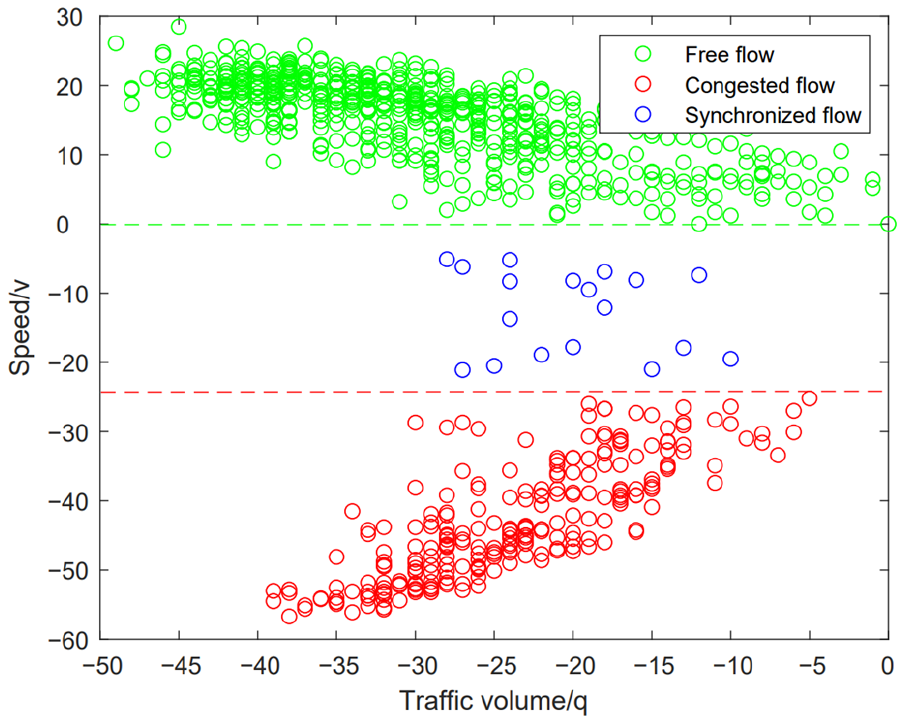
Figure 3. Extraction results of catastrophe boundary.